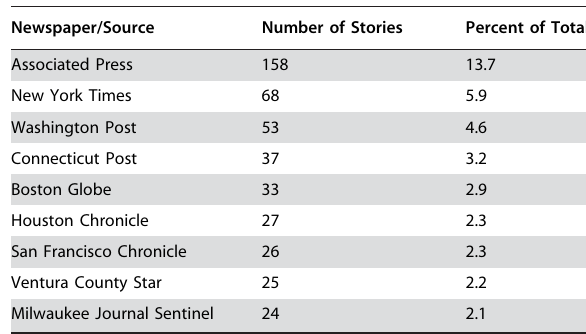
Table 5. Examples of researcher financial ties to private